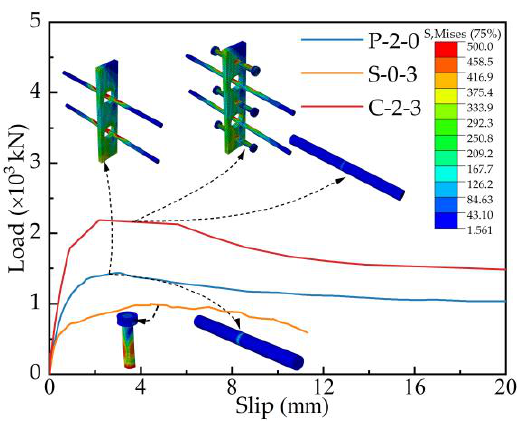
Figure 19. Failure modes of three shear connectors.